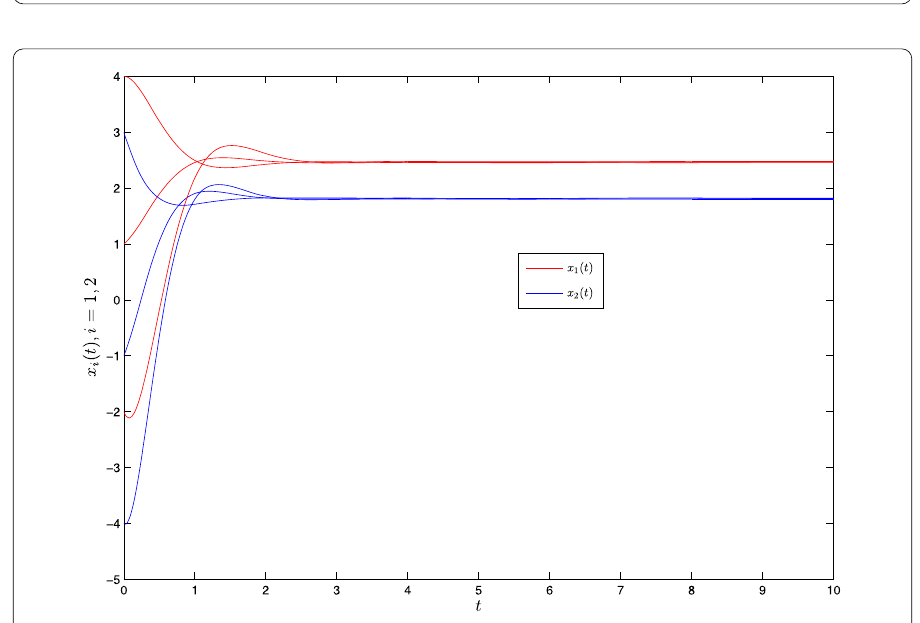
Figure 3 Numerical solutions x ( t ) on system (3.2). Numerical solutions x ( t ) to example (3.2) with initial values: (sin t + 1,–cos t – 3,cos t ,sin t ),(2cos t + 2,3sin t – 1,–2sin t ,3cos t ),(–3sin t – 2,–4sin t + 3,–3cos t ,–4cos t